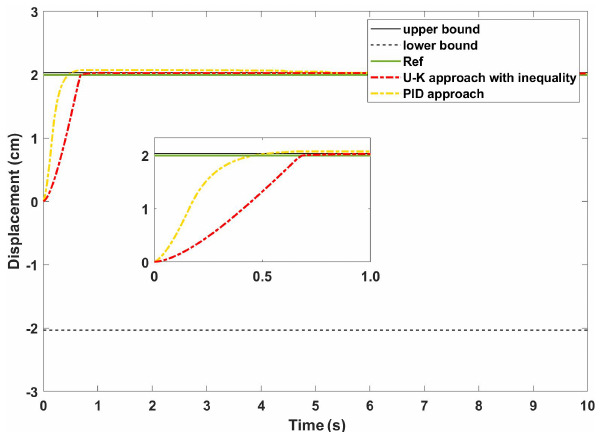
Figure 12. The control input of the transient performance of U–K with the inequality constraint and PID.